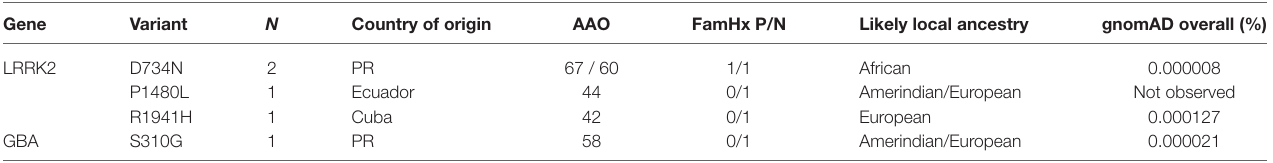
TABLE 3 | New variants (MAF < 1%) identified in selected exons of major PD genes. Gene